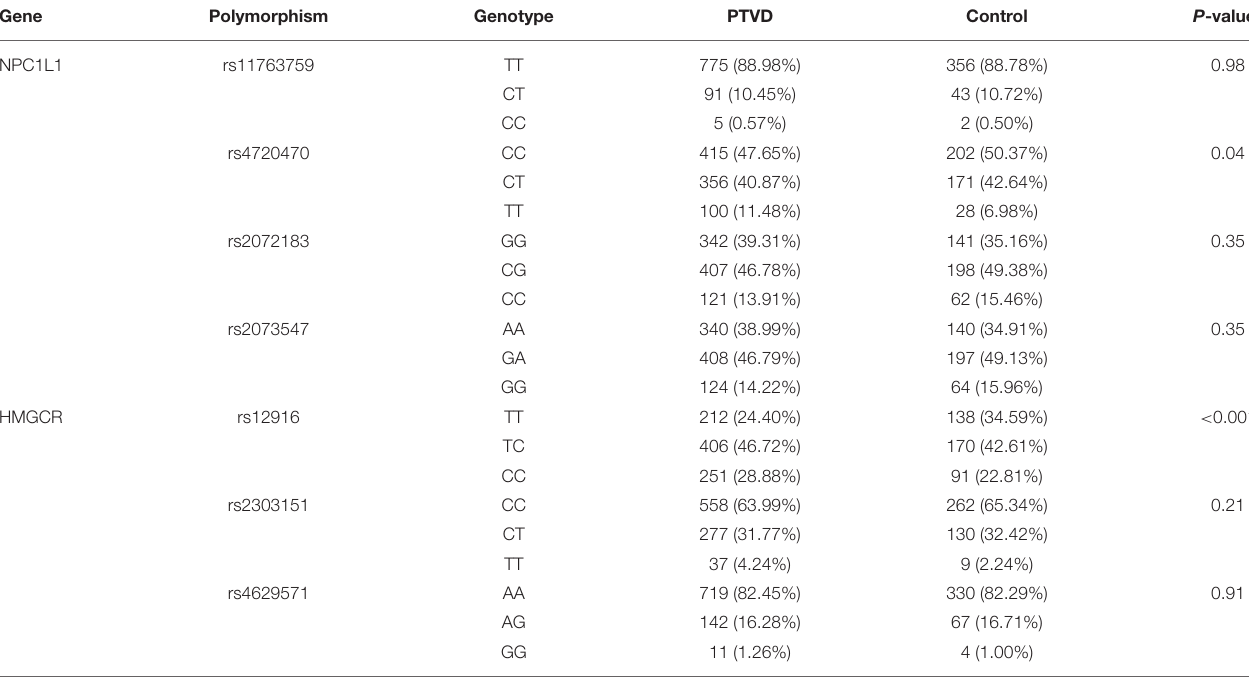
TABLE 2 | Frequency of genetic polymorphism in case-control patients. Gene